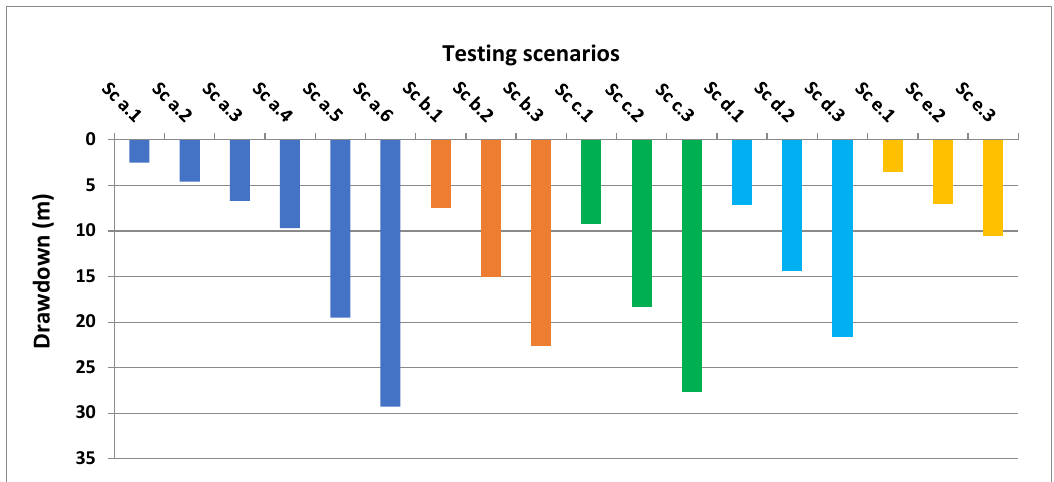
Figure 11. Predicted drawdown after 50 years for 18 scenarios.